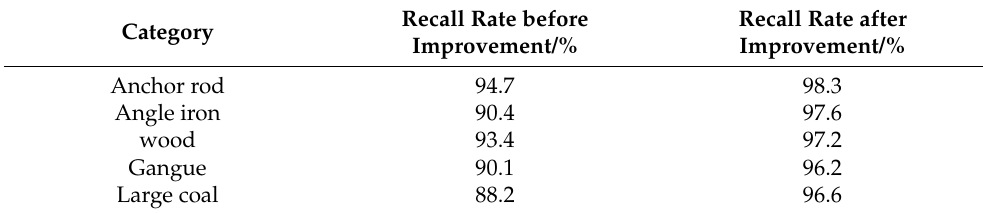
Table 4. Comparison of foreign objects recalls rate before and after